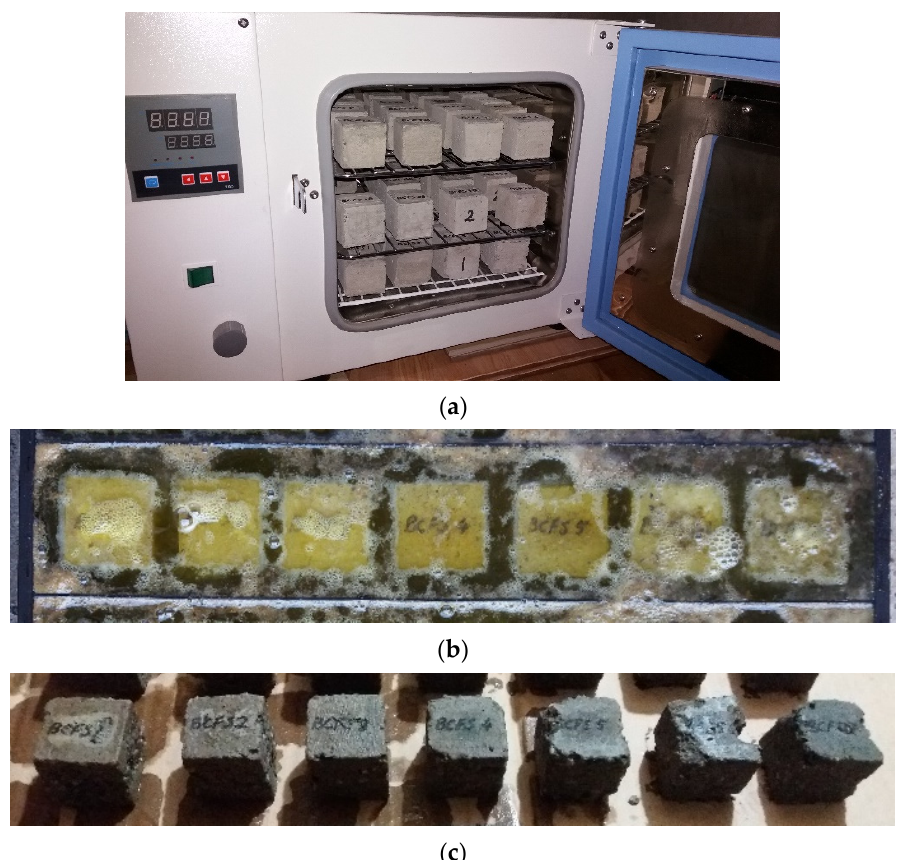
Figure 4. Resistance to the action of hydrochloric acid. ( a ) The specimens drying in an oven; ( b ) The specimens immersed in a 18% HCl solution; ( c ) The specimens after 10 days of immersion in the 18% HCl